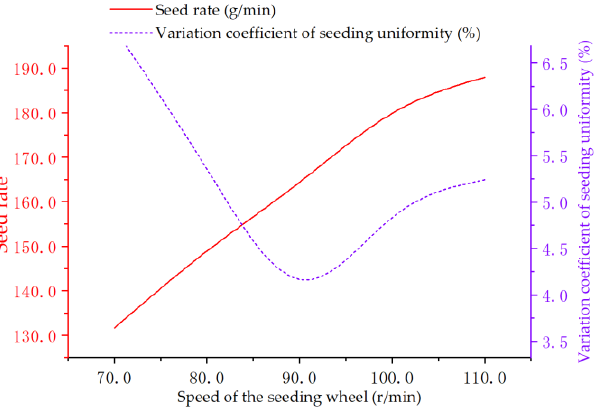
Figure 10. Relationship curve between the rotational speed of the seeding shaft and each index.